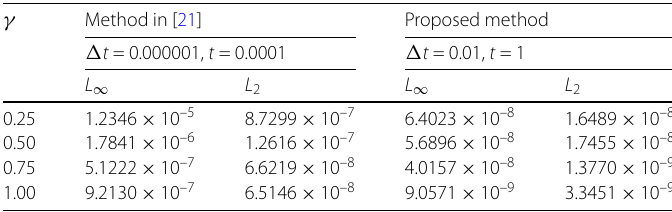
Table 1 Comparison of absolute error for Problem 1 when n = 100